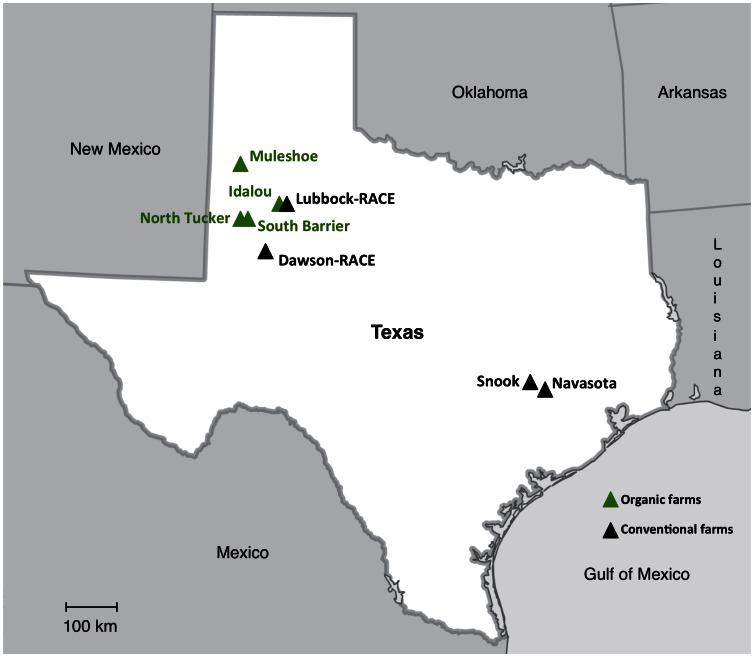
Map of survey area.Geographic location of the eight different cotton farms surveyed during the 2011 growing season in Texas, USA. Green symbols correspond to farms managed following organic practices and black symbols correspond to farms managed using conventional practices.